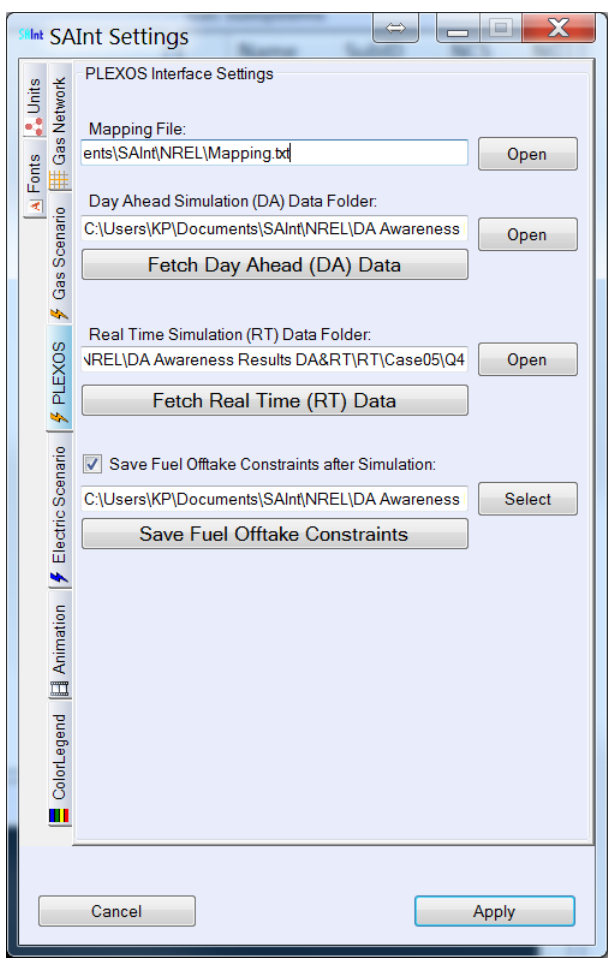
Figure 4. Snapshot of the co-simulation interface implemented into SAInt.